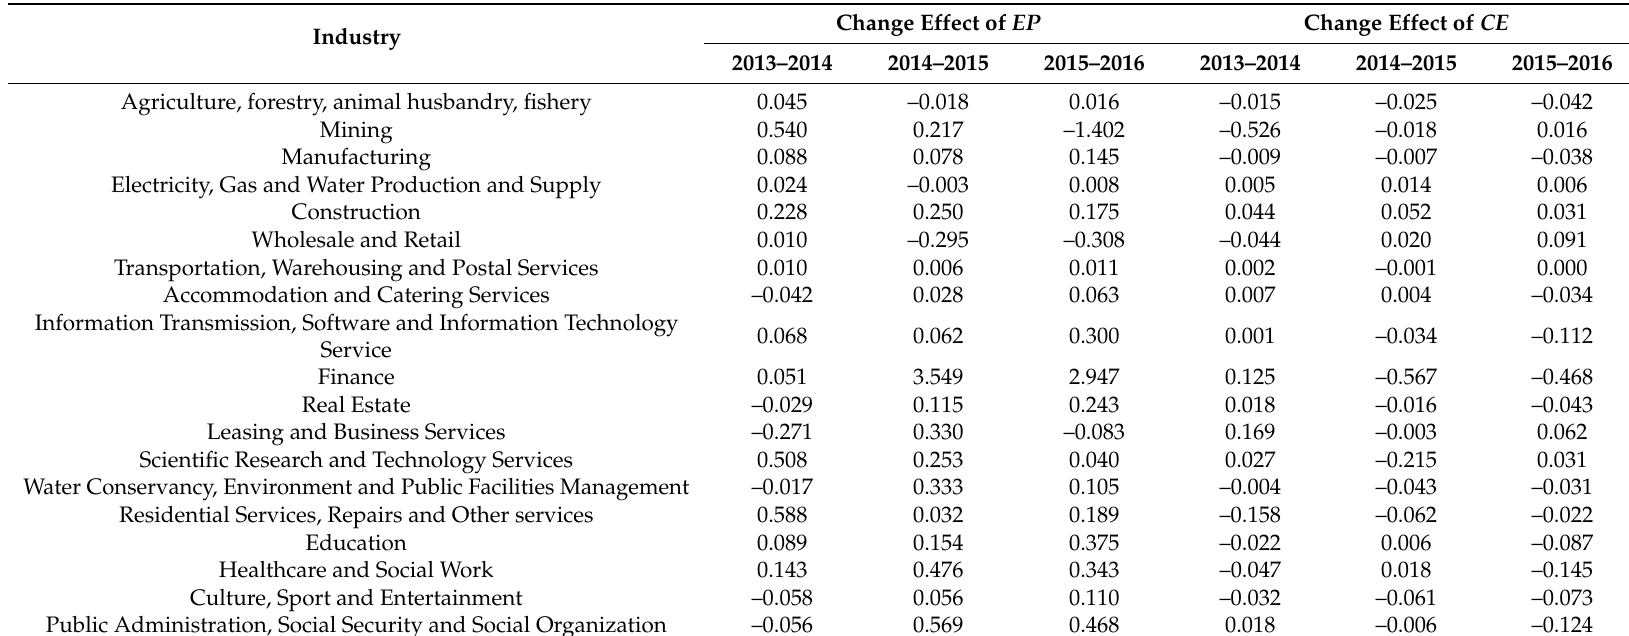
Table 8. The change effect of EP and CE in different industries